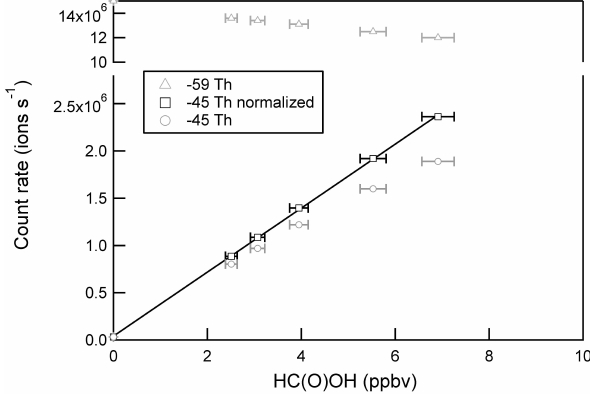
Fig. 4. Normalized calibration to formic acid (detected as HC(O)O − at − 45Th). Both the measured (gray circles) and nor- malized (black squares) count rate at − 45Th and the reagent ion count rate at − 59Th (gray triangles) are shown as a function of the formic acid